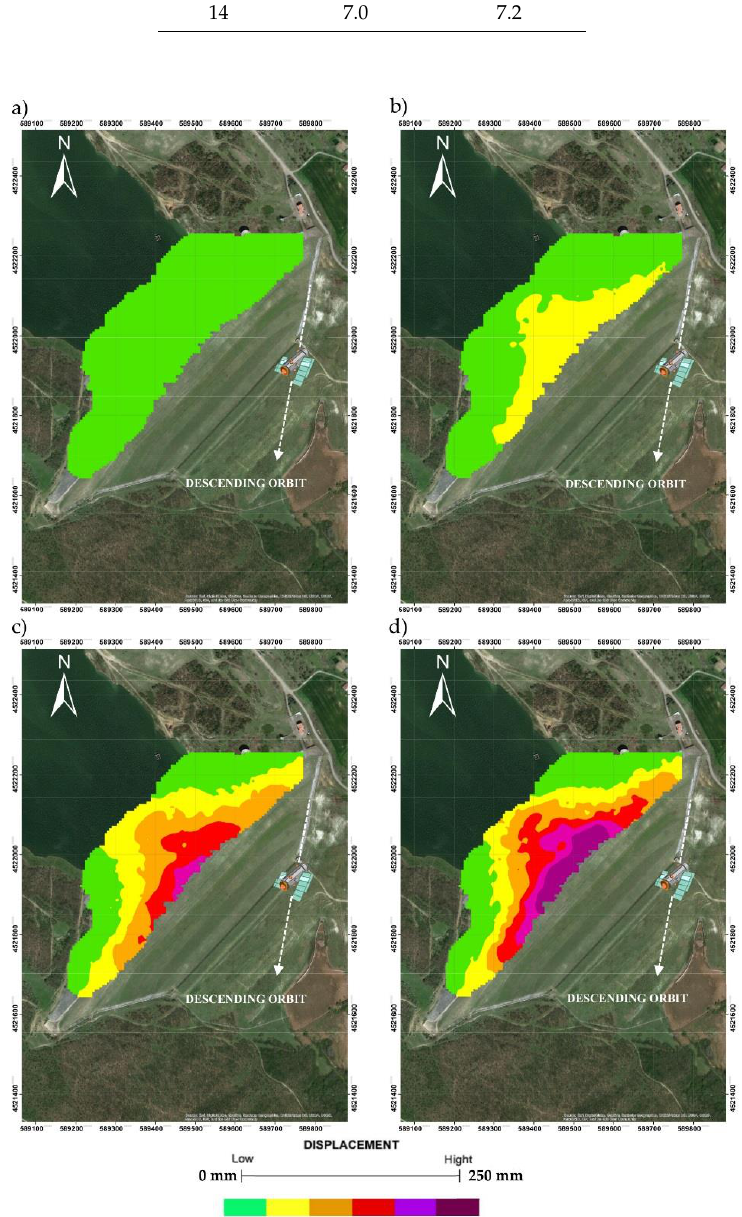
Figure 14. Spatio-temporal evolution of the deformation from the DInSAR observations, interpolation of punctual displacements data along the time: ( a ) 1992; ( b ) 1998; ( c ) 2002 and ( d ) 2007, the white dashed line indicates the satellite descending orbit (Nord–South).